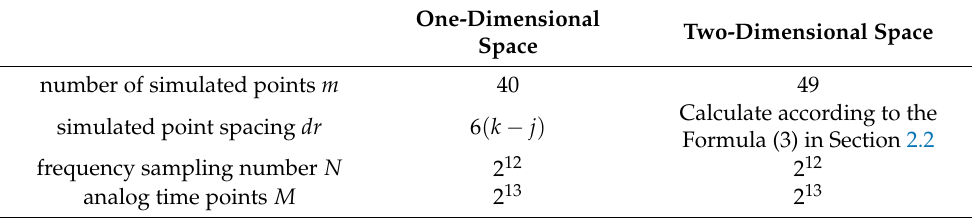
Table 3. Frequency domain simulation parameters.